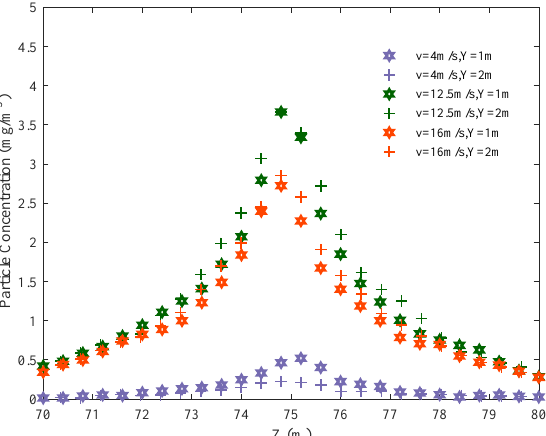
Figure 6. Horizontal concentration distribution (4 m/s, 12.5 m/s and 16